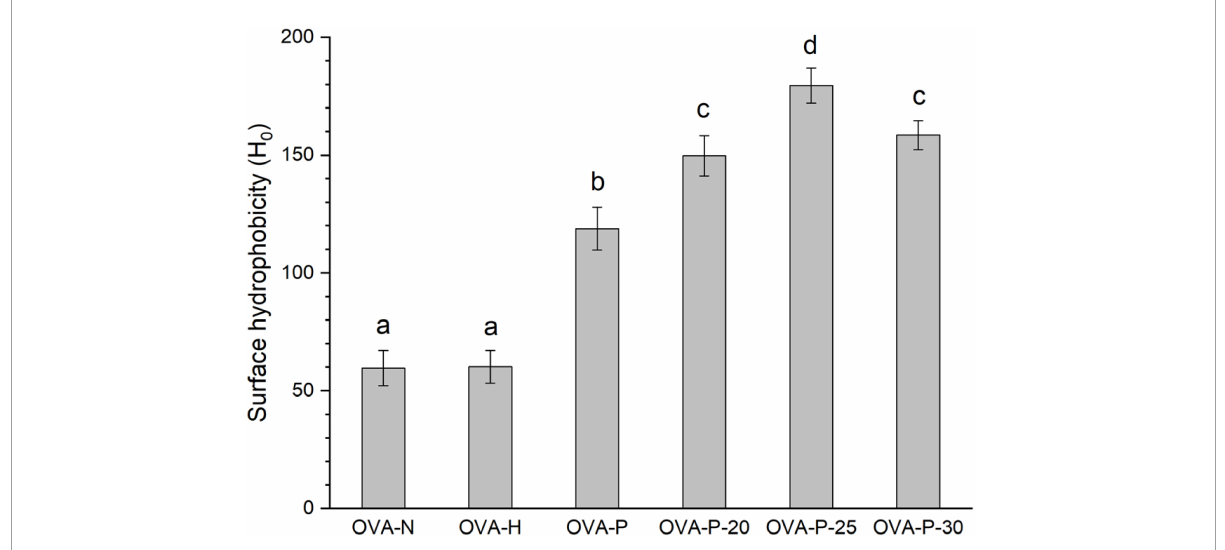
FIGURE5 Changes in surface hydrophobicity of the ovalbumin (OVA) samples. Different letters (a–d) on the top of the bars denote significant difference ( p <